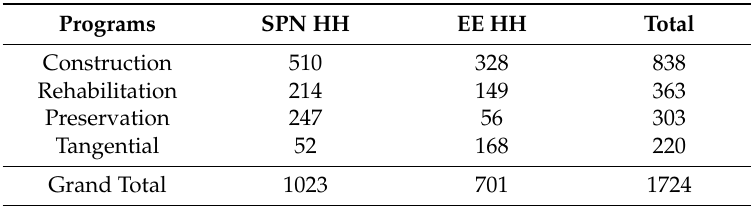
Table 4. Housing programs by identifications. The appendix lists the individual audience type by housing